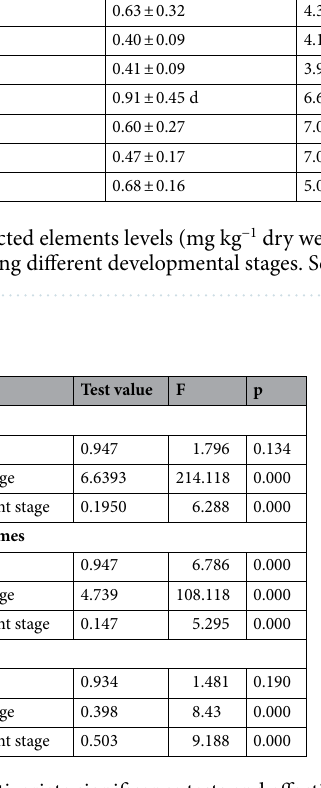
Table 5. Multivariate significance tests and effective hypothesis decomposition for three stages (adults, spawner, and kelt) for oxidative stress biomarkers parameters, lysosomal enzymes and elements of the muscle tissue of the sea